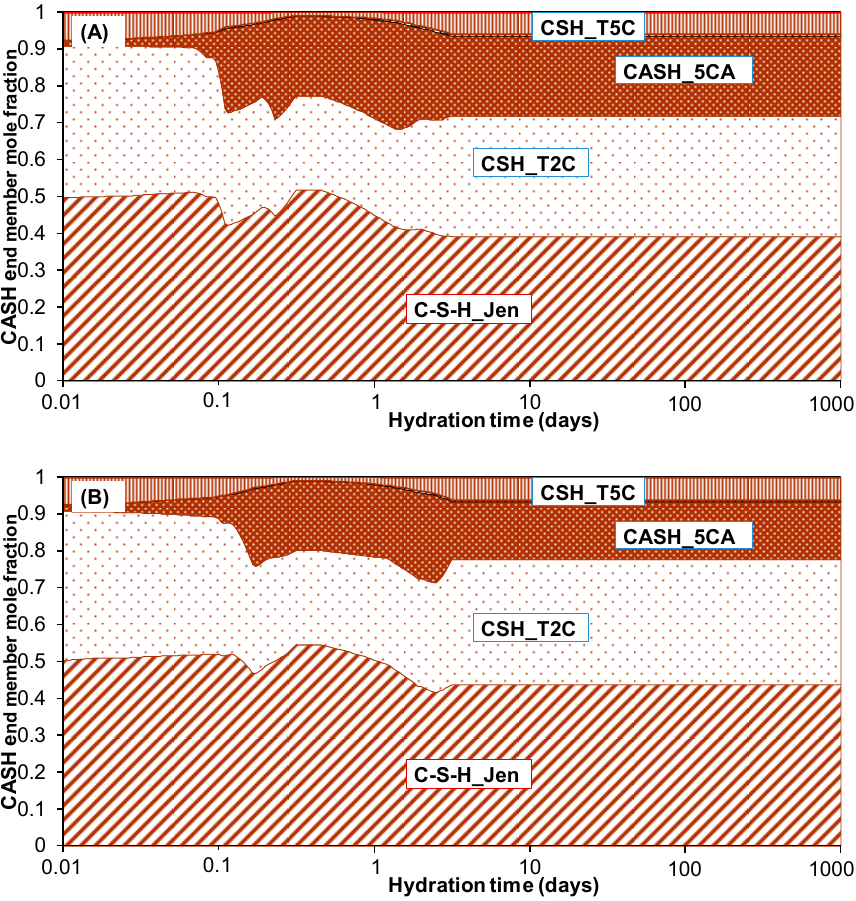
Figure 6. CASH end member of hydrating PC, ( A ) without Na 2 SO 4, and ( B ) with 25% of Na 2 SO 4 .